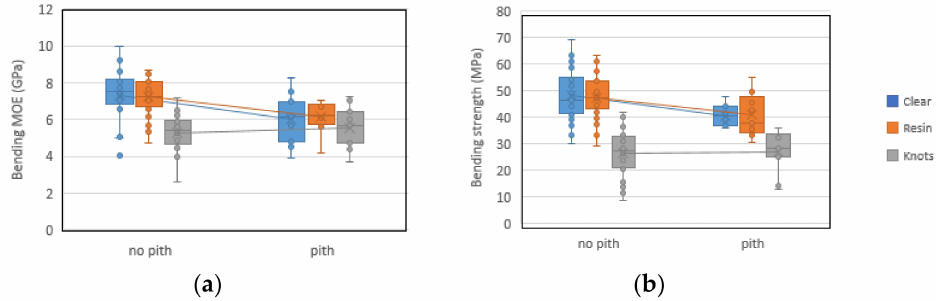
Figure 11. Box plots of bending properties with and without pith—( a ) MOE and ( b )